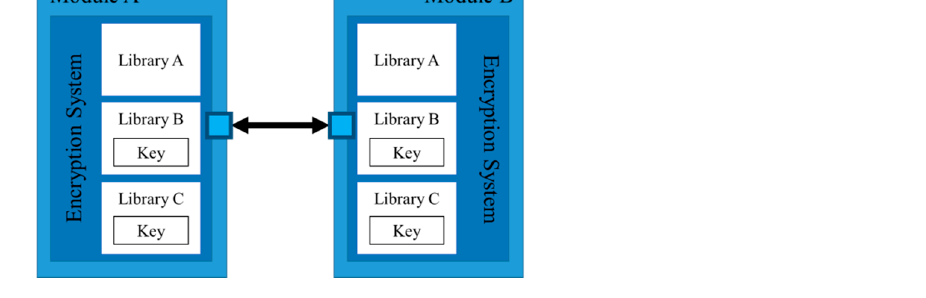
Figure 14. IoT module encryption system example illustration using multiple encryption technologies.